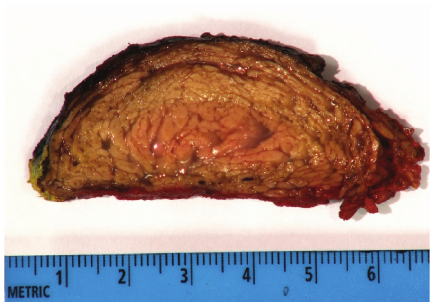
Figure 4: The cut surface of the gross specimen shows a circumscribed, yellow to tan, lobulated mass.